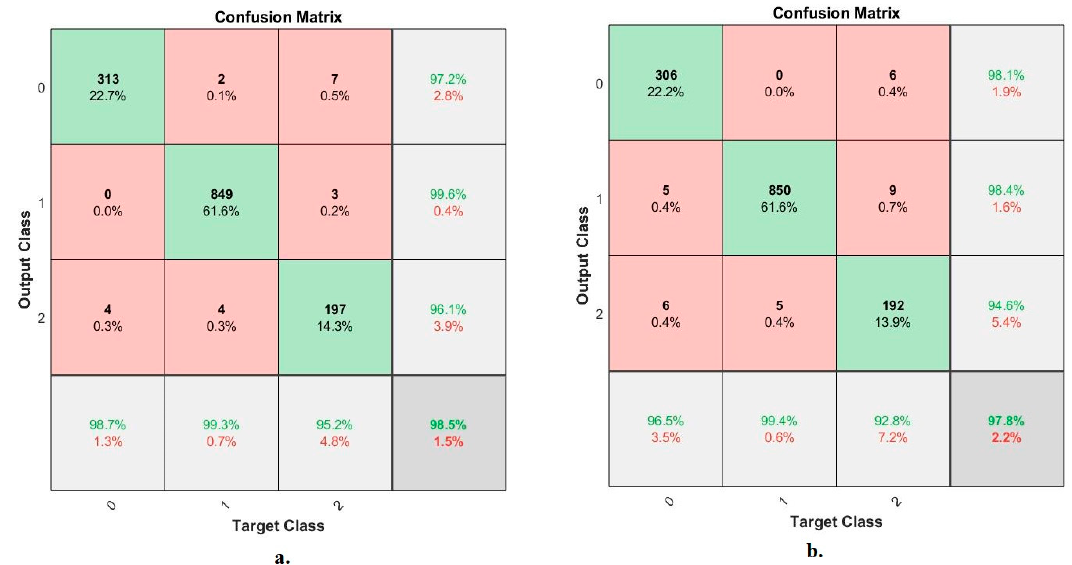
Figure 10. Confusion matrix displaying the ANN results for the diagnosis of X ‐ rays of pneumonia and tuberculosis based on deep feature integration, ( a ). VGG16 + ResNet18 before PCA algorithm; ( b ). VGG16 + ResNet18 after PCA algorithm.